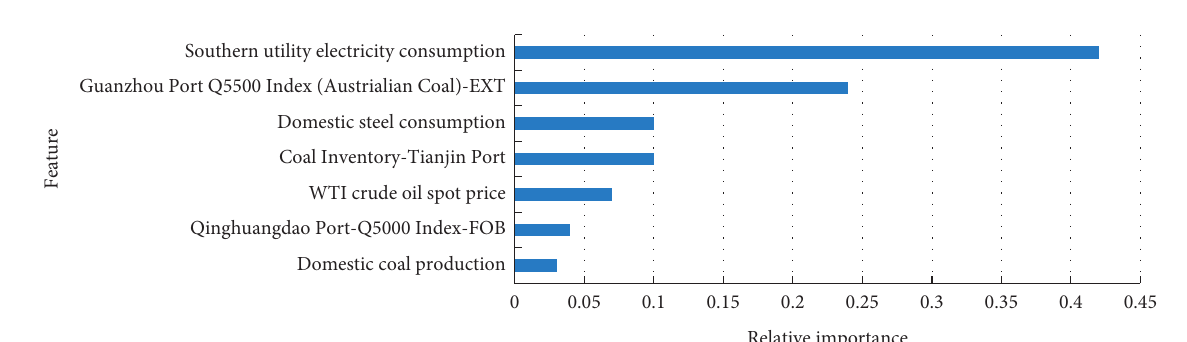
Figure 12: Feature importance for CBCFI monthly forecasting with adding demand and demand-related